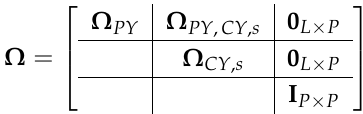
Table 6. Copula correlation matrix from the marginalized model. Correlation block for the marginalized model: Ω PY (Table 7); Ω PY , CY , s (Table 8); Ω CY , s (Table 9).